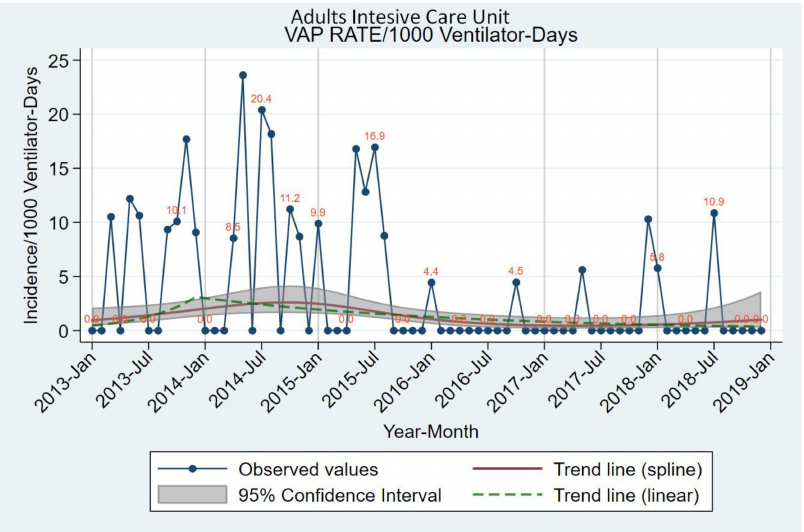
Figure 1. Observed values and estimated time trends of the incidence rate of VAP in the ICU, January 2013 to December 2018.VAP: ventilator-associated pneumonia; ICU: intensive care unit. Trends shown with dashed lines werederived from Poisson regression models with robust standard errors, seasonality terms and linear or piecewise linear long-term trend: log(N) = β 0 + β 1 t − + β 2 t + + β 3 × sin(2 π t/12) + β 4 × cos(2 π t/12) + β 5 × sin(4 π t/12) + β 6 × cos(4 π t/12) + log(ventilator-days) with N being the number of cases and t being time since study start in months (t − and t + piecewise linear time terms). Trends shown with grey area werederived similarly but spline terms of time were used for long term trend instead of piecewise linear